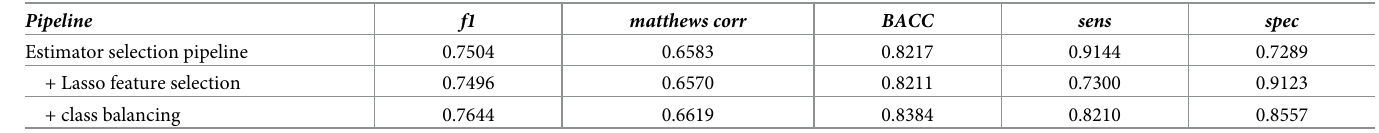
Table 1. Validation performance metrics for three different pipeline